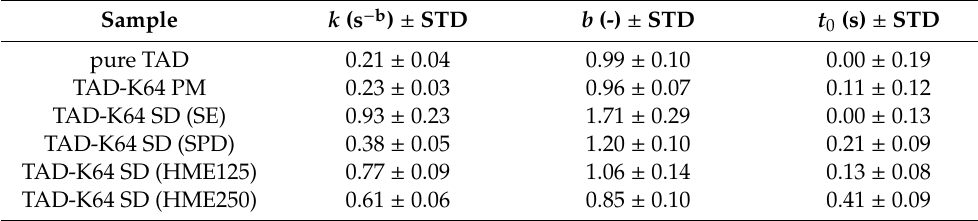
Table 4. Kinetic parameters of TAD release (K64 polymer matrix).